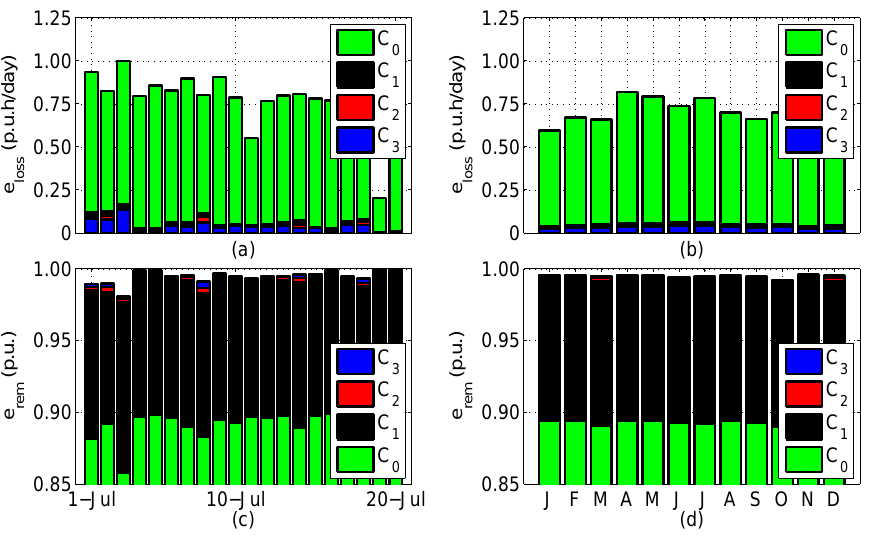
Figure 19. USPVP energy losses due to FR during a year in Puerto Rico, for several ESS scenarios: C at 0.00277 p.u.h ( C 1 ), 0.00833 p.u.h ( C 2 ), 0.015 p.u.h ( C 3 ) and without BESS ( C 0 ): ( a ) Daily energy